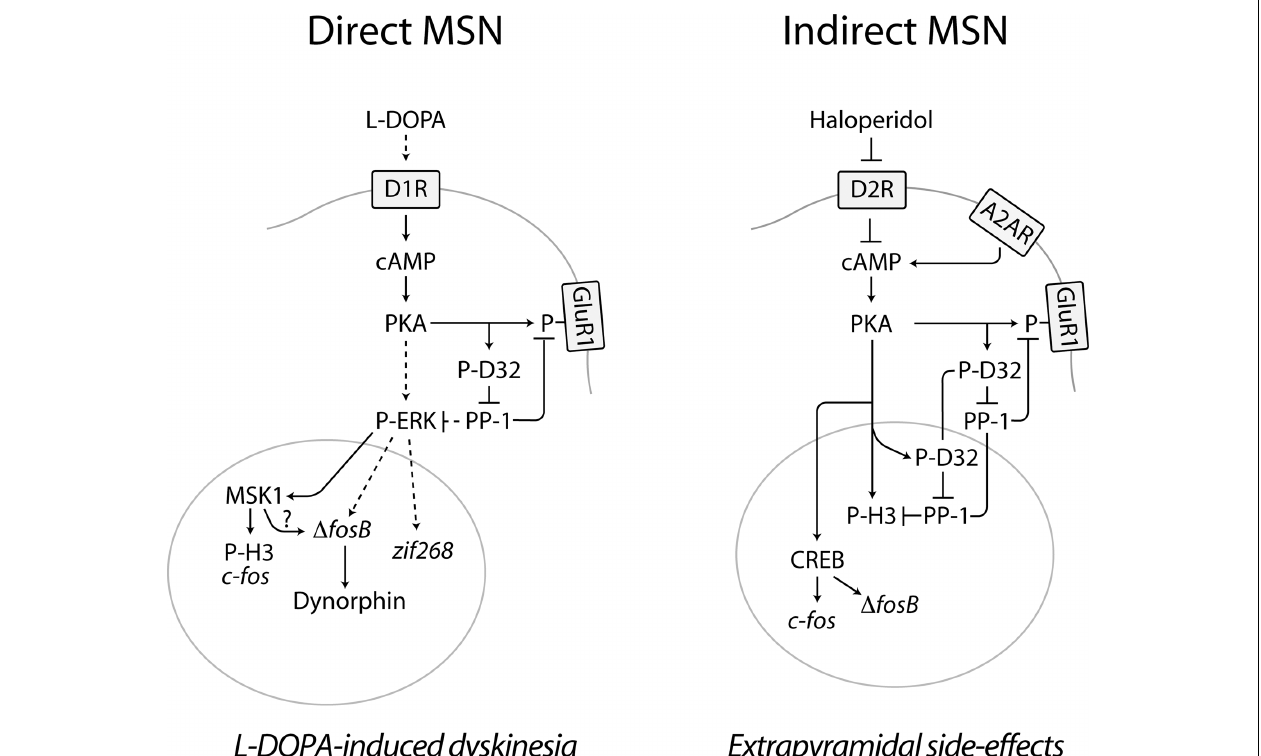
of MSK1 results in phosphorylation of histone H3 at Ser10 and enhanced expression of c-fos (Santini et al., 2007). Activation of ERK also increases the expression of zif268 and (cid:2) fosB , which has been associated to LID (Andersson et al., 1999; Carta et al., 2005). Increased (cid:2) FosB, in turn, leads to enhanced levels of dynorphin (Andersson et al., 1999). In the indirect striatopallidal MSNs, the regulation of histone H3 and gene expression exerted by haloperidol occurs independently of the ERK/MSK1 cascade.Thus, histone H3 is regulated via PKA-catalyzed phosphorylation and by concomitant suppression of dephosphorylation, via DARPP-32-mediated inhibition of PP-1 (Bertran-Gonzalez et al., 2009). In addition, the ability of haloperidol to activate PKA leads to increased phosphorylation of the cAMP-response element binding protein (CREB), which may be involved in the control of Fos expression (Konradi and Heckers, 1995).The control of multiple signaling pathways exerted by L-DOPA and haloperidol in the MSNs of the direct and indirect pathway may ultimately modify the activity of these neuronal populations, leading to abnormal motor responses, including L-DOPA-induced dyskinesia and extrapyramidal side-effects. Broken lines indicate indirect effects. See text for